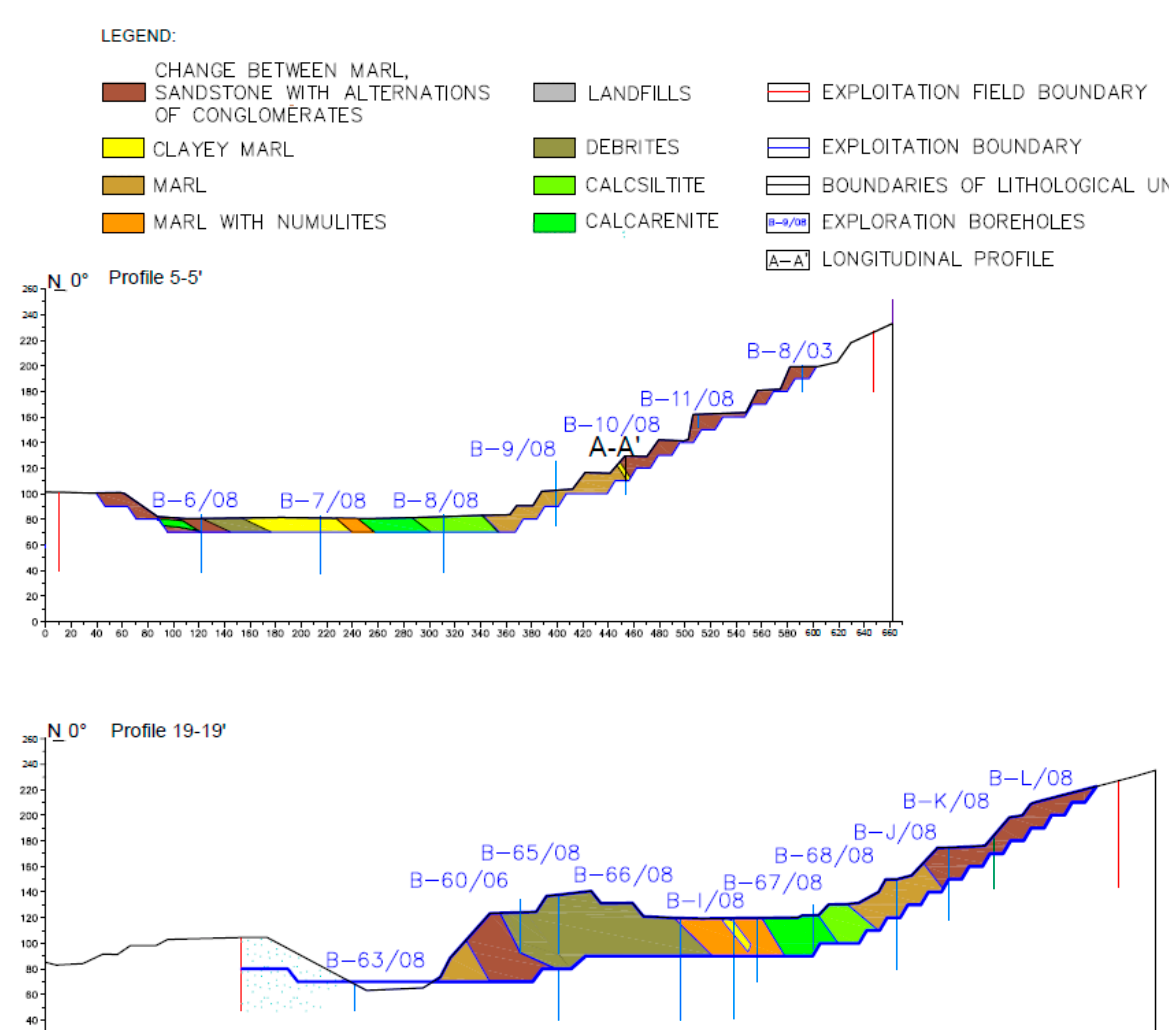
Figure 4 . Average thickness of lithological units in the analysed layers.